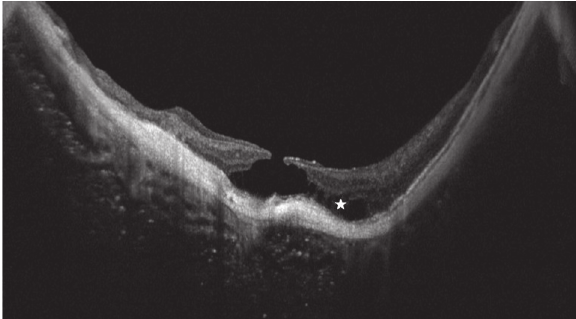
Figure 4: Full-thickness myopic macular hole. In this SD-OCT scan, the myopic profile and staphyloma of the posterior pole are evident. The sclera and the choroid are very thin. The white star highlights the initial stage of a myopic foveal